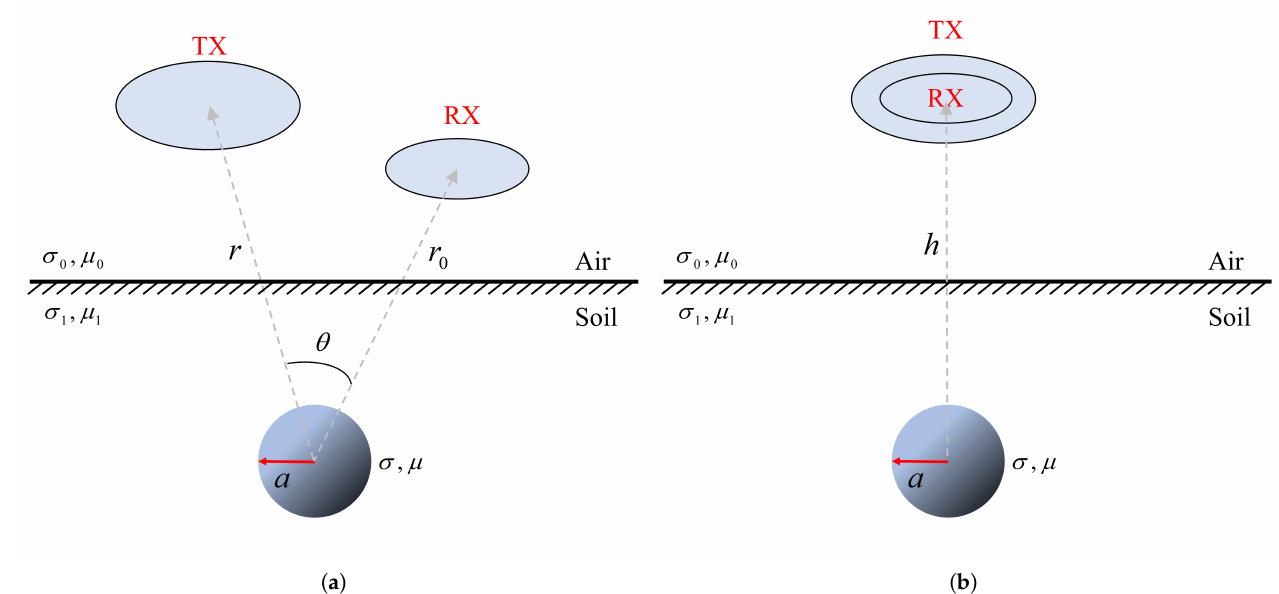
Figure 1. The response model of a solid conductor sphere. ( a ) Bistatic sensor; ( b ) monostatic sensor. The complex expression X n + iY n in Formulas (2)–(5) is called the response function, and contains the electromagnetic properties and size of the sphere. Other terms in the formula are all real, and are only determined by the relative position between the sphere, the transmitter, and the receiver. The real part X of the response function is the in-phase response, and the imaginary part Y is the quadrature response. For a solid,